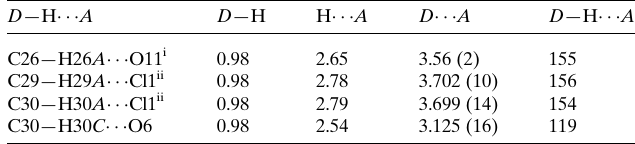
Table 8 Hydrogen-bond geometry (A˚ , (cid:4) ) for 1 .